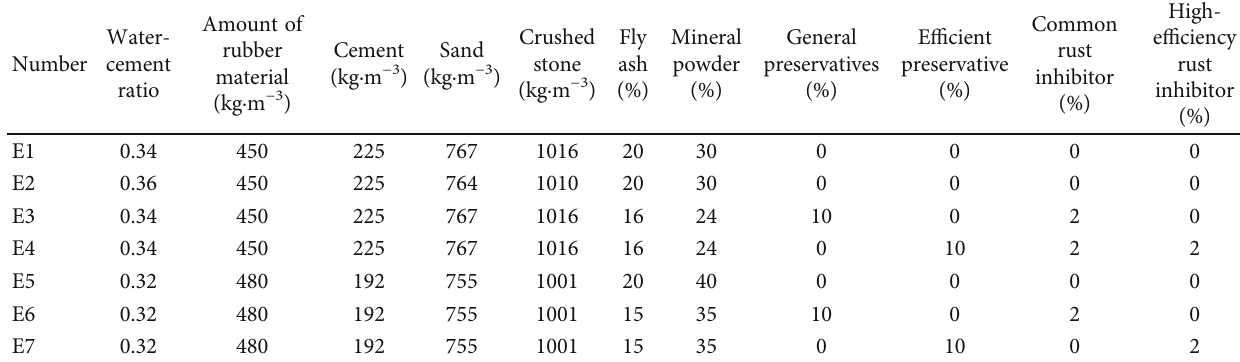
Table 4: Concrete mix proportion and speci fi c gravity of admixture.